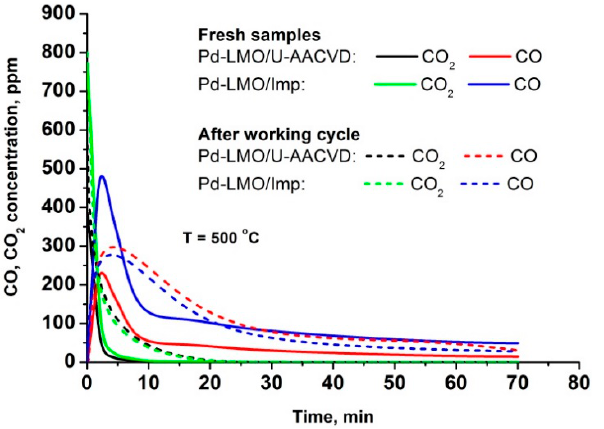
Figure 6. Reductive activation of Pd-LMO/U-AACVD and Pd-LMO/Imp in CH 4 /N 2 flow.